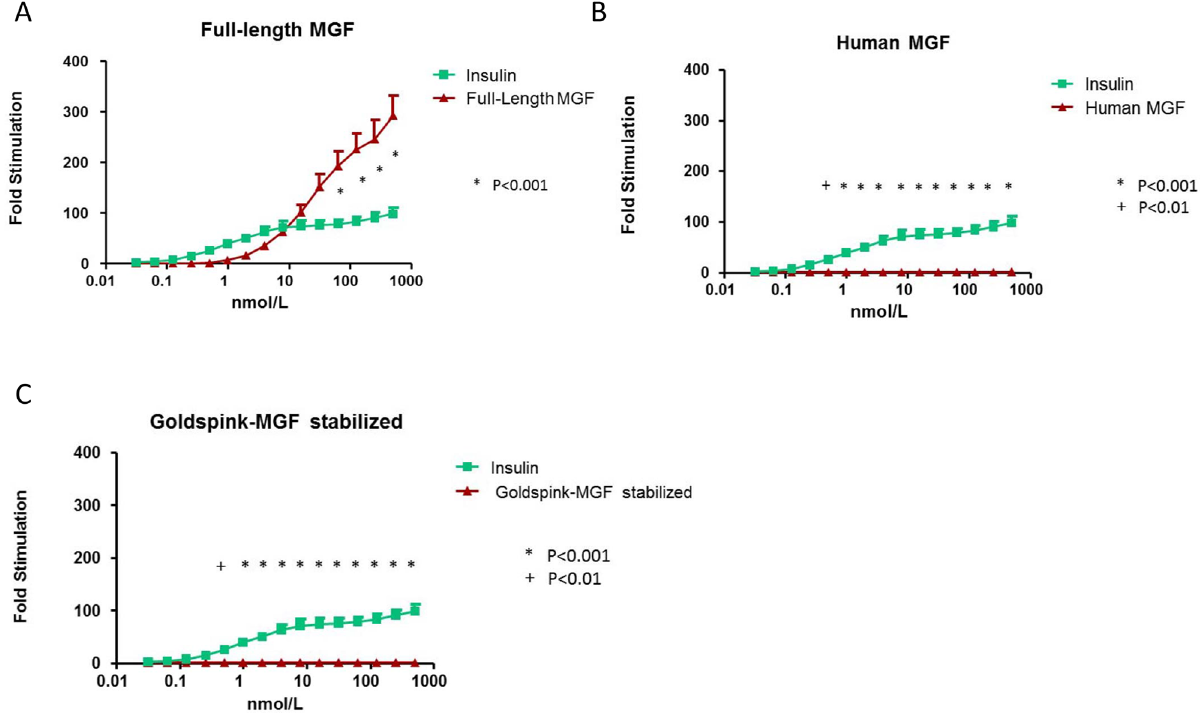
Fig 4. Stimulatory activity of the insulin receptor-B (IR-B). A: Comparison of full-length MGF (red points and line) and insulin (green points and line). B: Comparison of Human MGF (red points and line) and insulin) (green points and line). C: Comparison of Goldspink-MGF (red points and line) and insulin (green points and line). Dose-response curves ranged from 0.03125 nmol/L to 500 nmol/L. For bioactivity measurements means ± SEM and signal-to-noise ratios are presented. A-C: Each point represents the mean value ± SEM of at least three independent experiments. P = P-value when comparing overall differences in fold stimulation between two ligands.